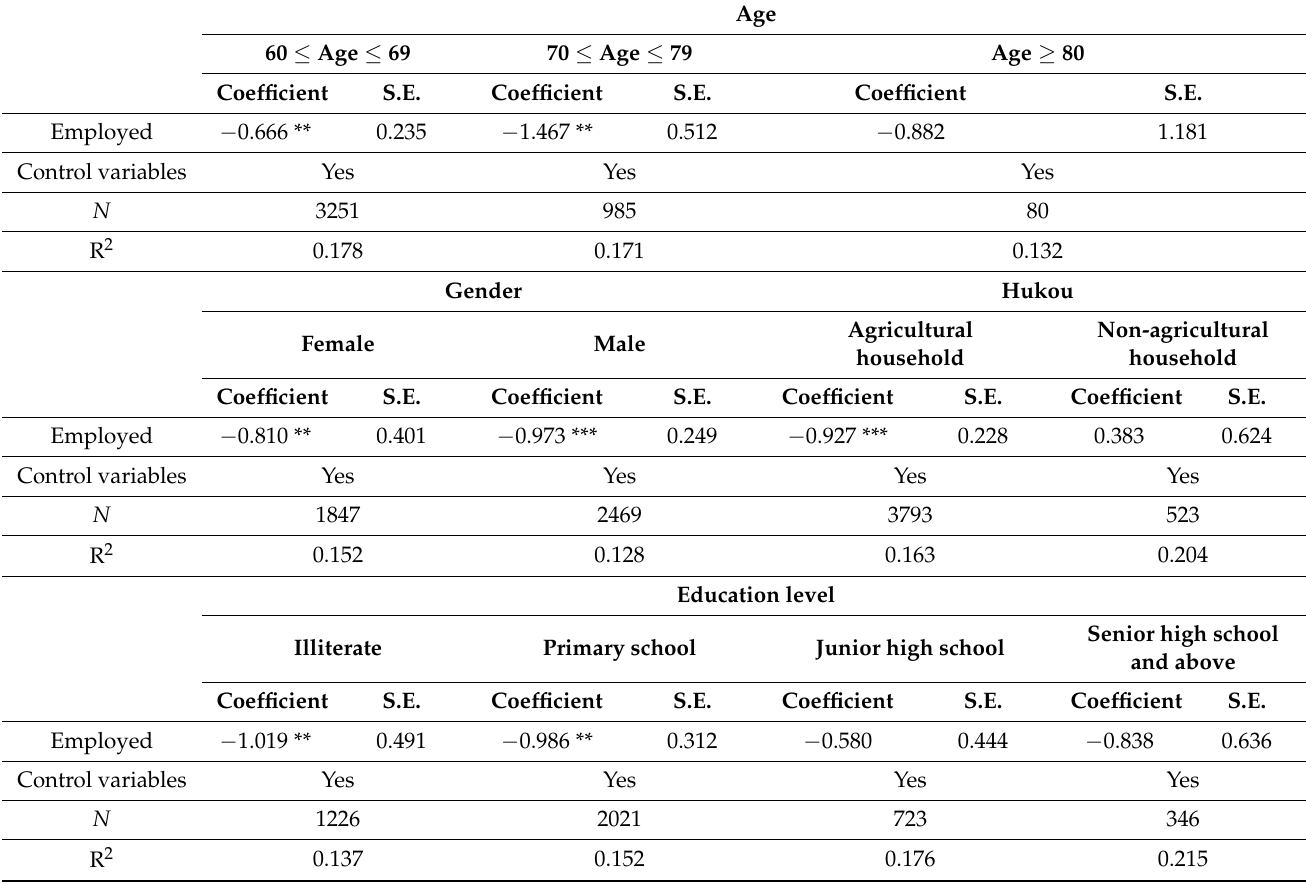
Table 6. Heterogeneity test